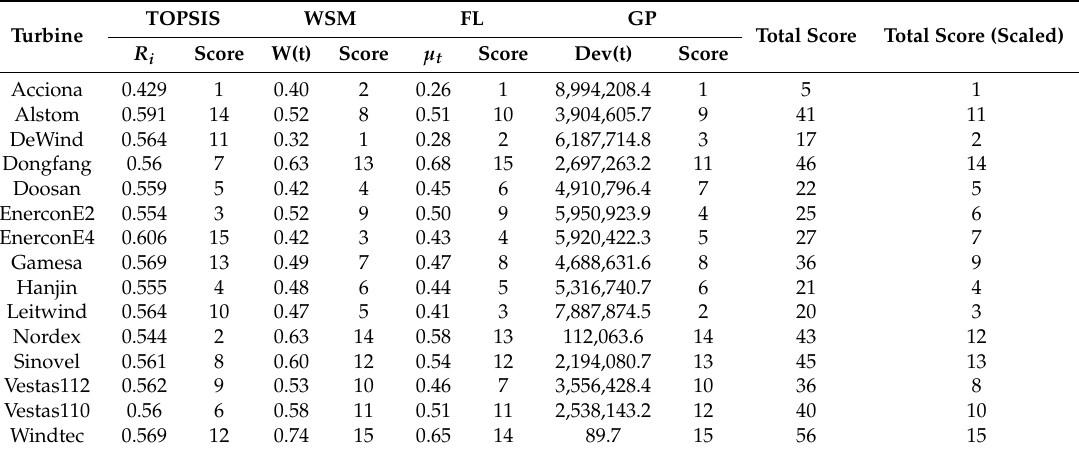
Table 5. The scores in terms of different methods for Turaif.